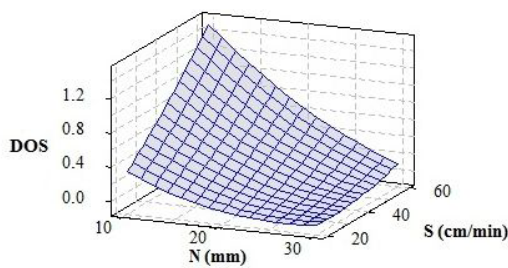
Figure 5. Response surface for interaction effect of welding speed ( S ) and nozzle to plate distance ( N ) on degree of sensitization ( DOS ) ( W = 8.5 m/min; V = 29.5 V).